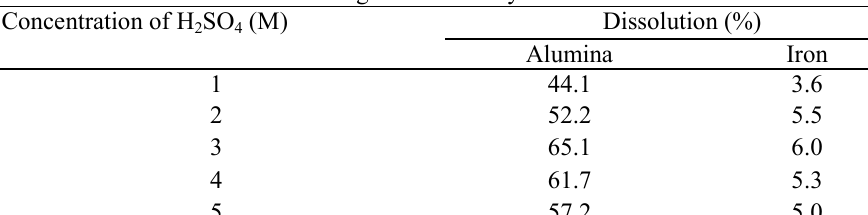
Table 3. Effect of acid concentration on the dissolution of alumina and iron from clay calcined at 750 o C for 30 min using an acid to clay ratio of 40 wt% at 80 o C for 30 min. Concentration of H SO (M) 2 4